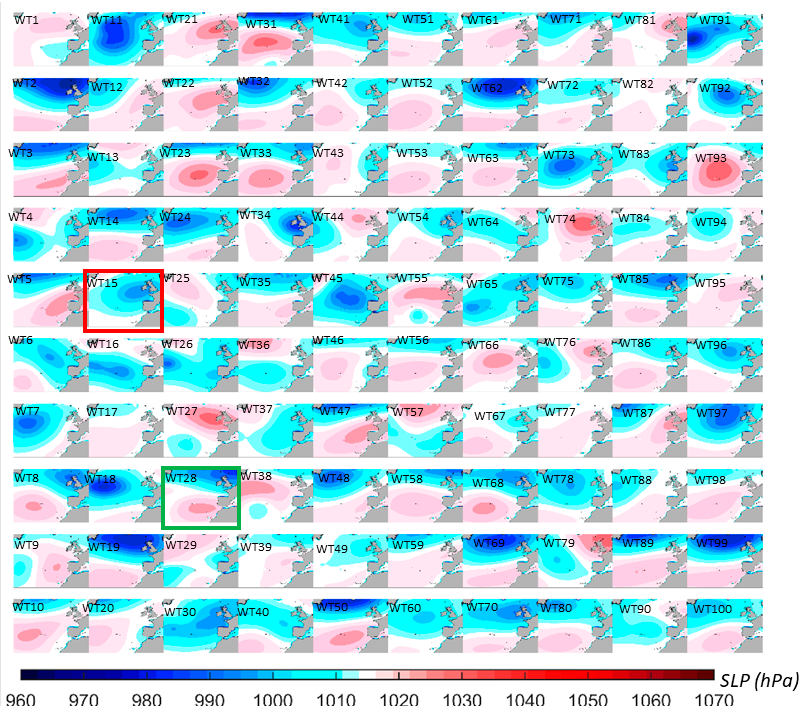
Figure A1. Daily mean SLP associated with each of the 100 weather types of the SD3 model, using a semi-supervised regression classification. Calibration period: years from 2000 to 2014, excluding 2012, which is the validation period. WT 15 and WT28 show the atmospheric pattern of Xynthia (red rectangle) and Joachim (green rectangle) storm, respectively. J. Mar. Sci. Eng. 2019 , 7 , x FOR PEER REVIEW